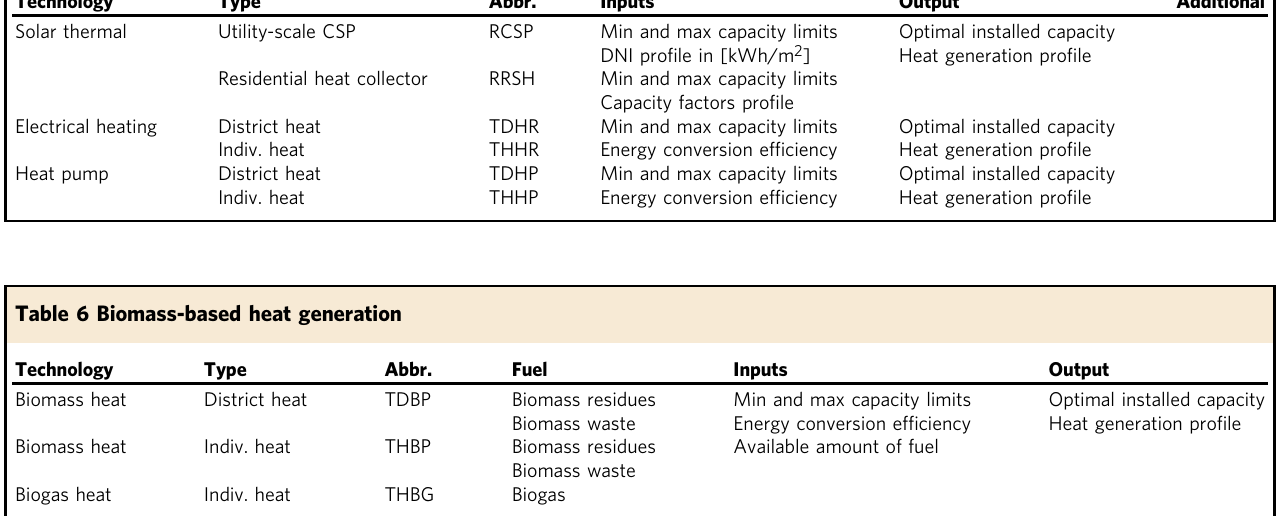
Table 5 Renewables/power-based heat generation Technology